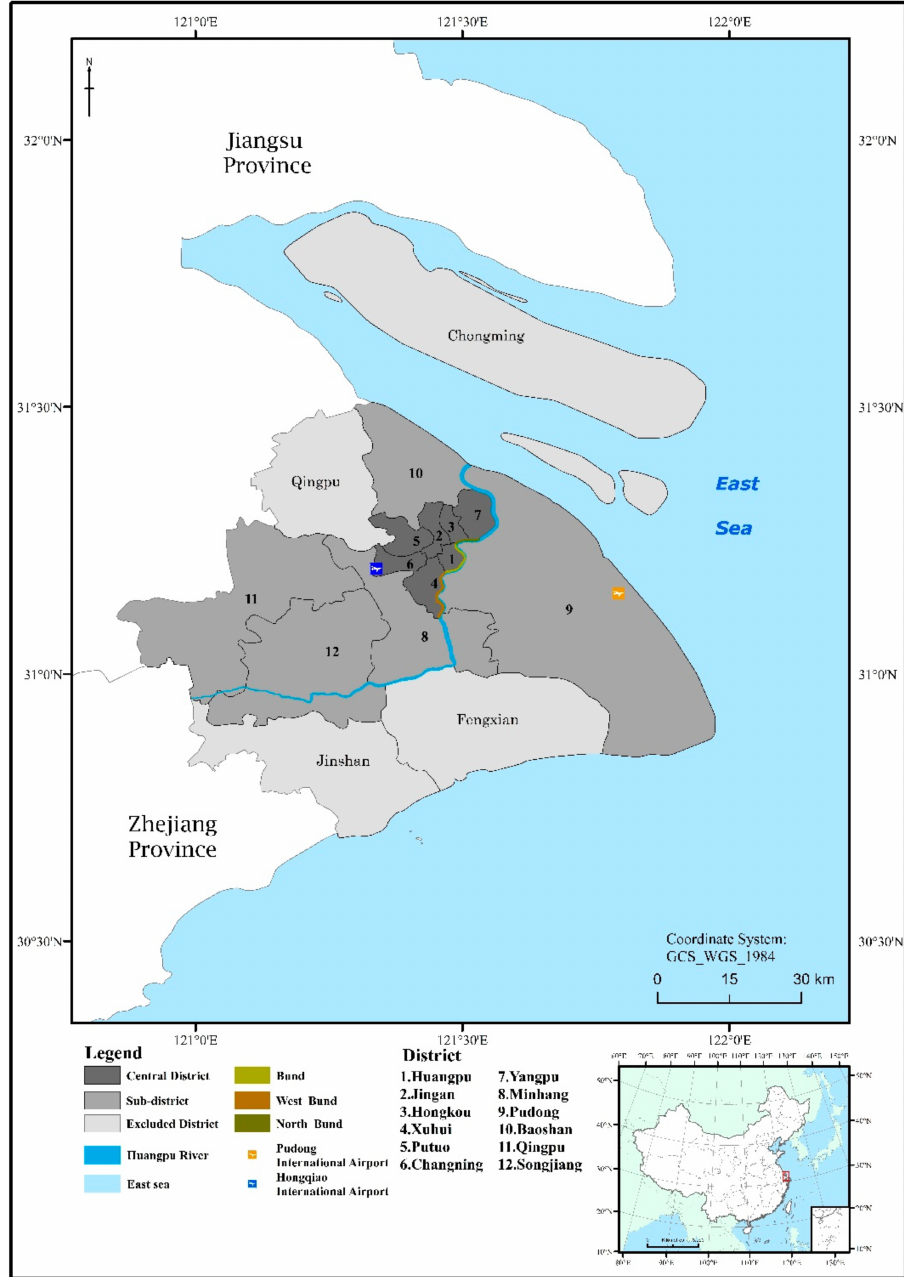
Figure 2. Shanghai municipality with its 16 administrative districts. Note: There are 16 administrative districts in Shanghai, of which there are seven central districts and nine